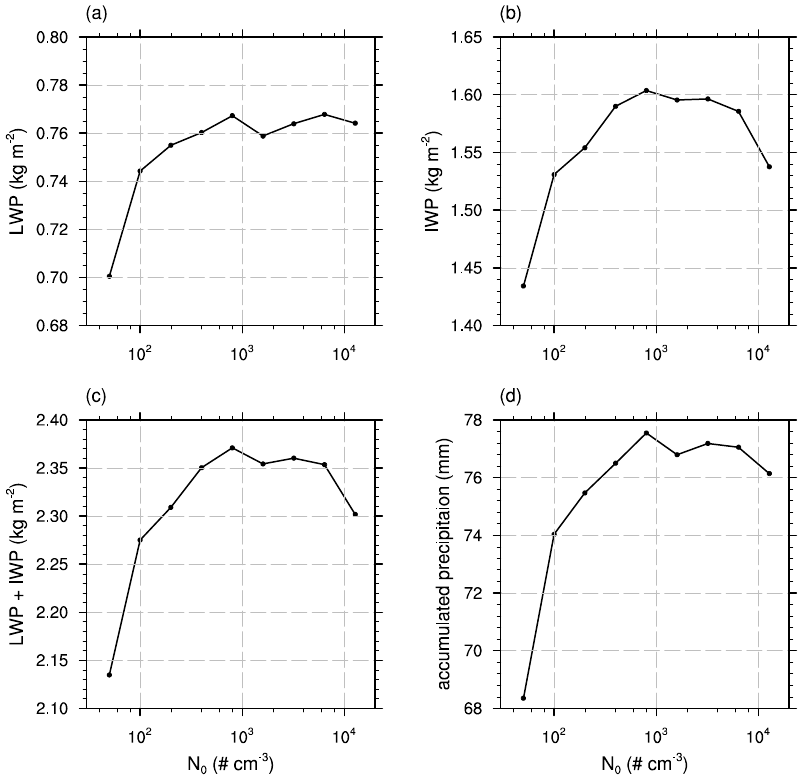
Figure 6. ( a ) Liquid water path (LWP), ( b ) ice water path (IWP), ( c ) the sum of the LWP and the IWP, and ( d ) accumulated surface precipitation amount averaged over the analysis region as functions of N 0 .